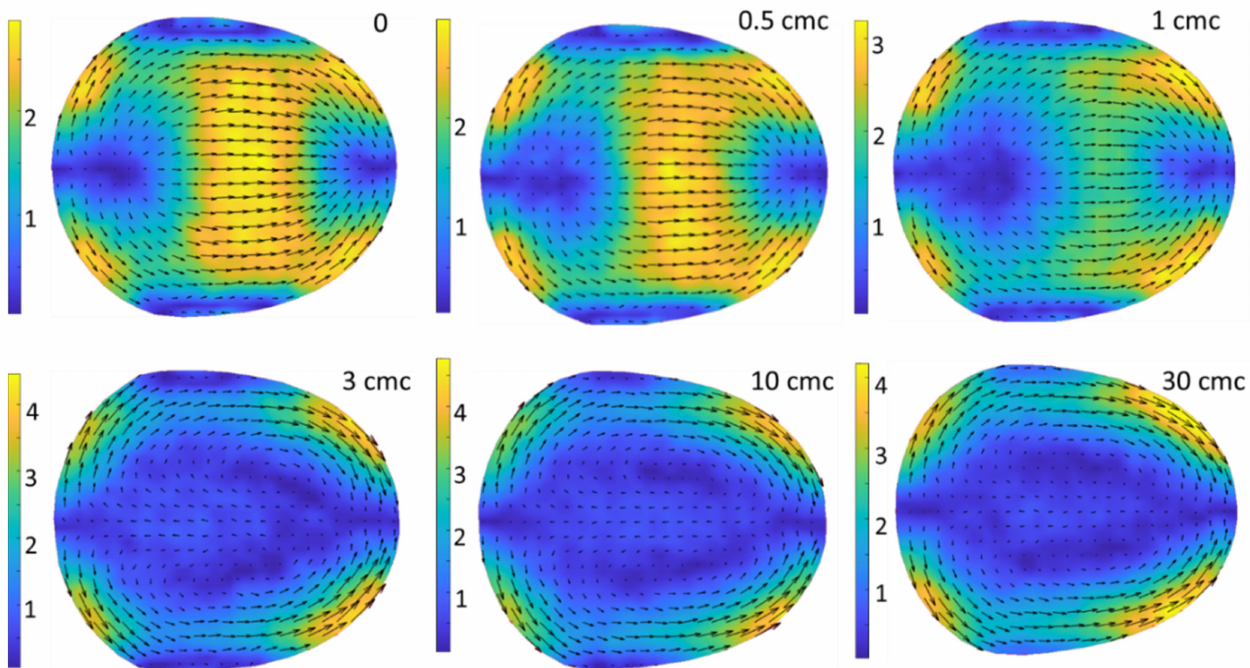
Figure 10. Flow patterns in the middle plane of a drop moving inside the channel depending on Tween 20 concentration in the coordinate system moving with the drop. Surfactant concentration is shown at each panel. Velocity on the color bar is given in mm/s. Drop velocities V d = 10.1 ± 0.3 mm/s, drop lengths L = 384 ± 3 µ m.